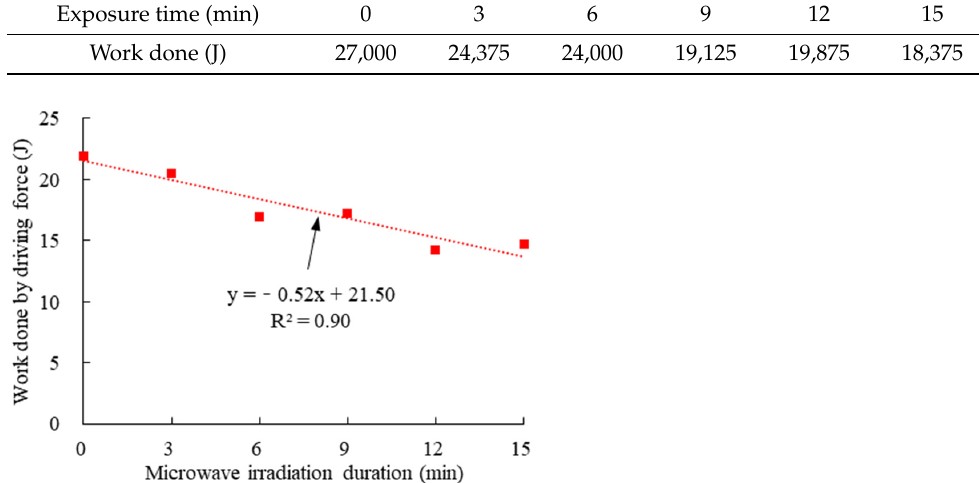
Figure 13. Relationship between the work done by the driving force and the microwave exposure time.